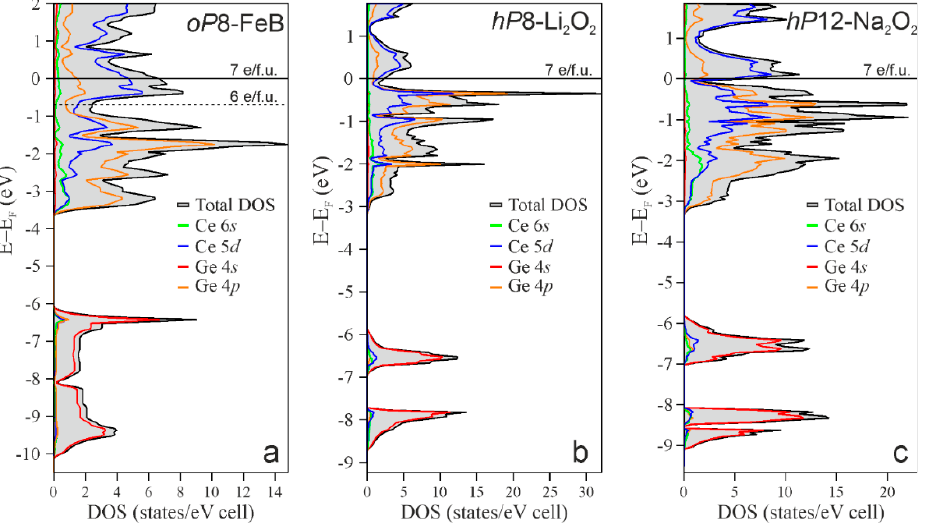
Figure 3. Total and orbital-projected electronic density of states for CeGe with the oP 8-FeB structure ( a ) and simulated as hP 8–Li 2 O 2 ( b ) and as hP 12–Na 2 O 2 ( c ). Calculated DOS curves indicate in all cases a metal-like behavior but with a noticeable difference: Li 2 O 2 (Figure 3b) and Na 2 O 2 (Figure 3c) show a pseudogap at the Fermi level, as typically expected for metallic germanides formally accomplishing the Zintl for- malism [75–77]. Conversely, the pseudogap in the DOS of CeGe (FeB) occurs at